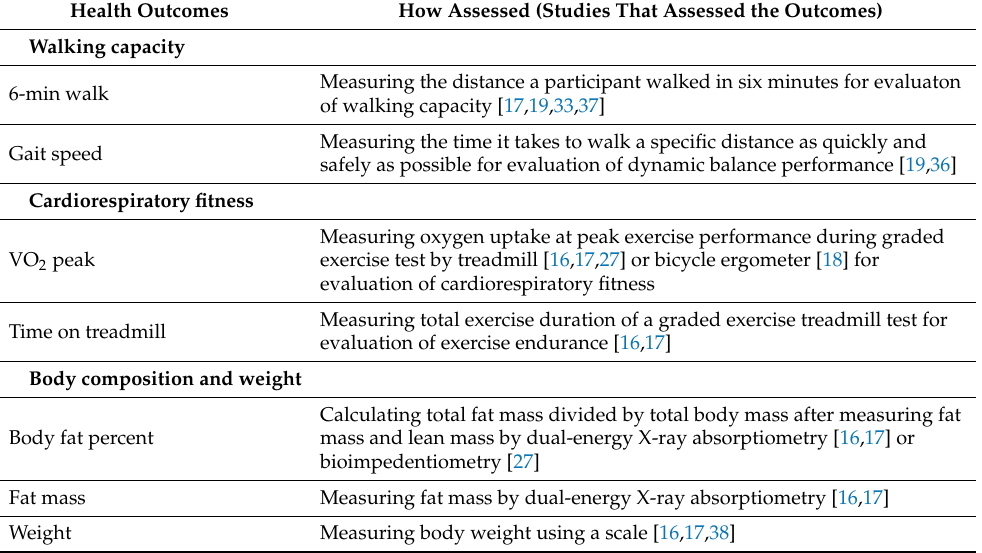
Table 3. Health outcomes assessed in the included